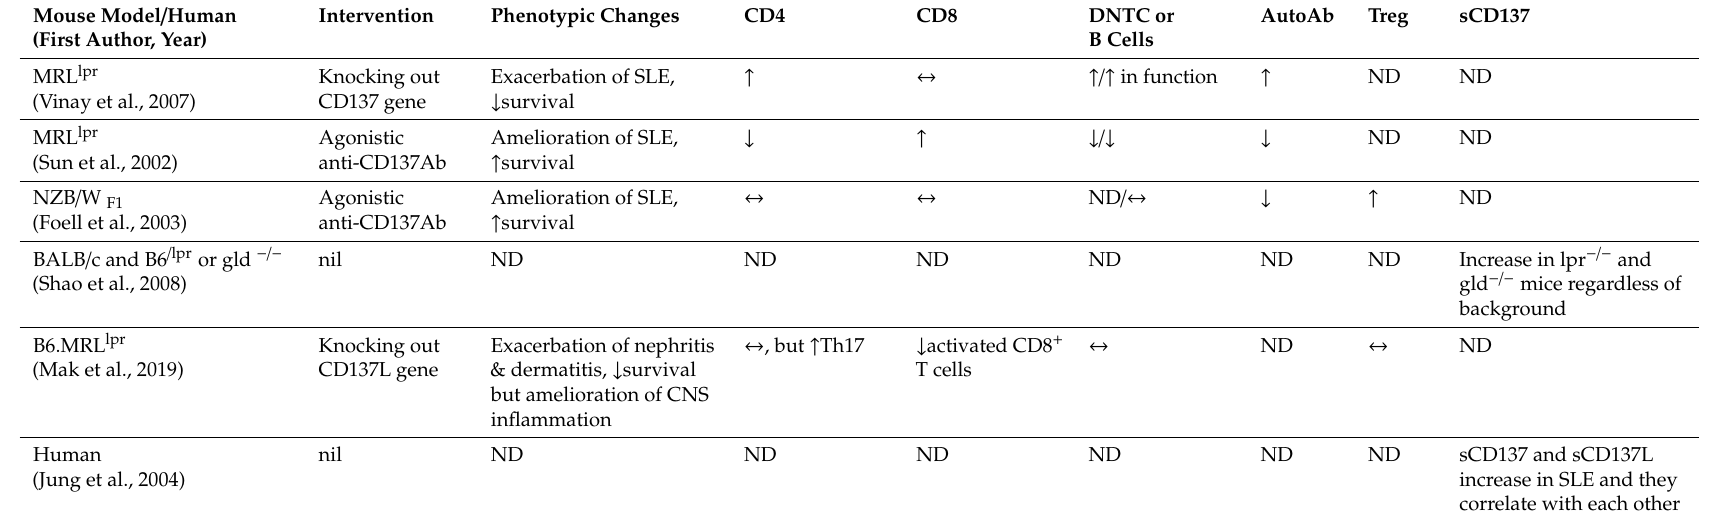
Table 1. Studies on CD137 manipulation in animal and human systemic lupus erythematosus